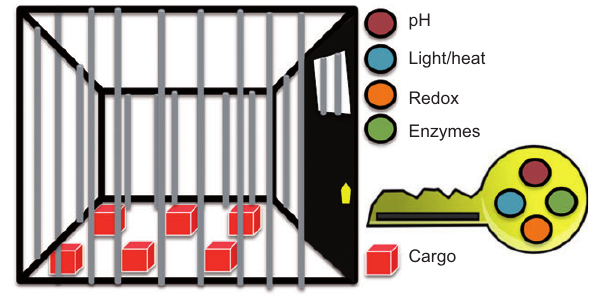
Figure 1 “ Caged cargo molecules ” that are released by specifi c triggers.